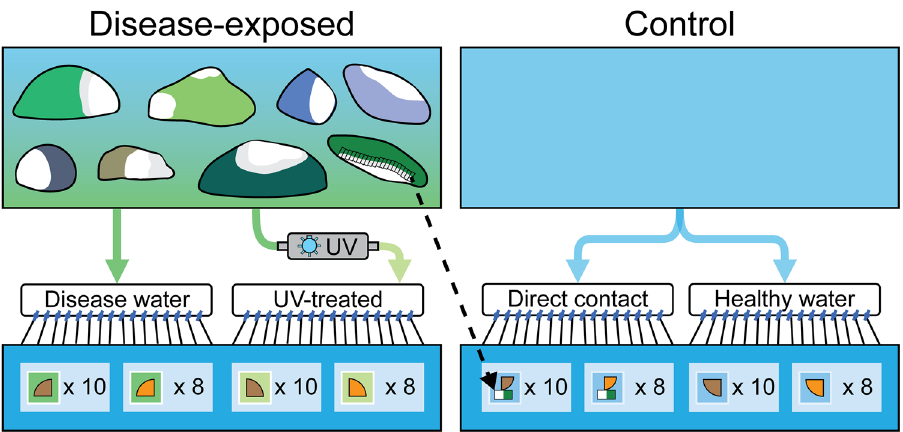
Figure 1. UV experiment infographic. SCTLD transmission apparatus in the Experimental Reef Laboratory at the University of Miami’s Cooperative Institute for Marine and Atmospheric Studies. Disease water generation using field-collected colonies of Montastraea cavernosa exhibiting SCTLD lesions (top), subsequent separation of water treatments and in-line UV treatment using Sanitron S17A 3-GPM UV system (middle), and exposure of water treatments to randomized fragments of Orbicella faveolata (brown) and Pseudodiploria strigosa (orange) in individual 0.5 L vessels with independent water sources from manifold systems